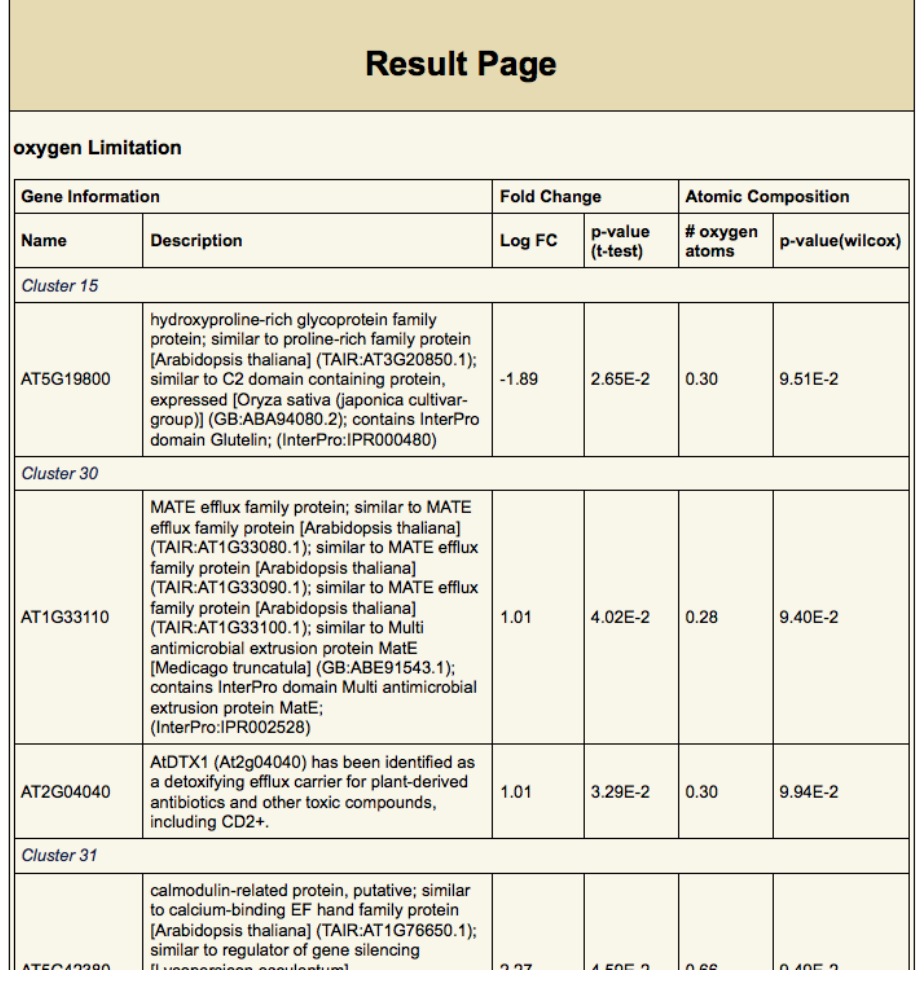
Figure 2: Nutrilyzer Result Page (part). Table including all paralogs that are significantly different expressed under nutrient limitation and also contain a significant different amount of this nutrient in their amino acid